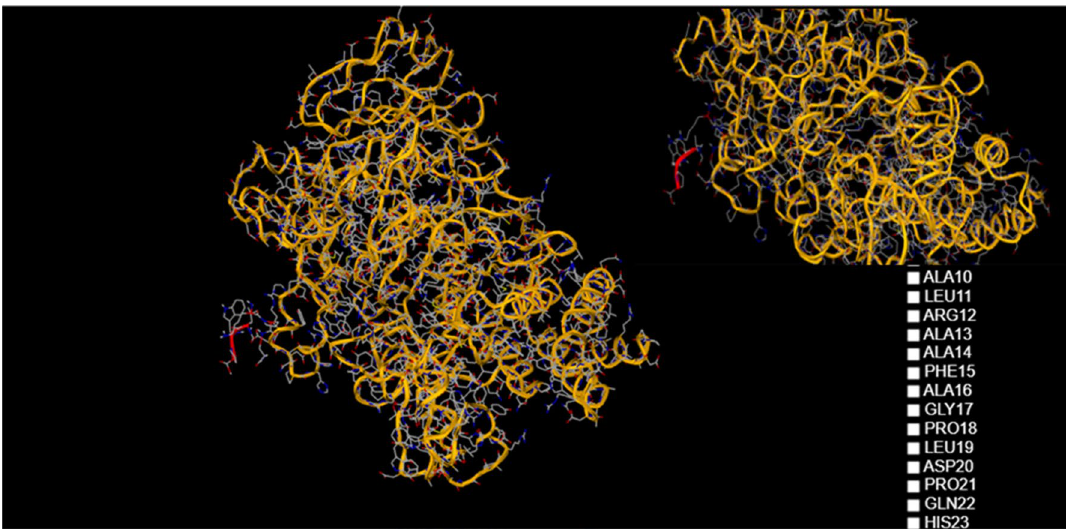
Figure 13. Result of the first docking experiment, with a score of -3.21 obtained using 1-CLICK DOCKING Software from the mcule platform, version from 2011, https:// mcule. com/ apps/1- click- docki ng/.